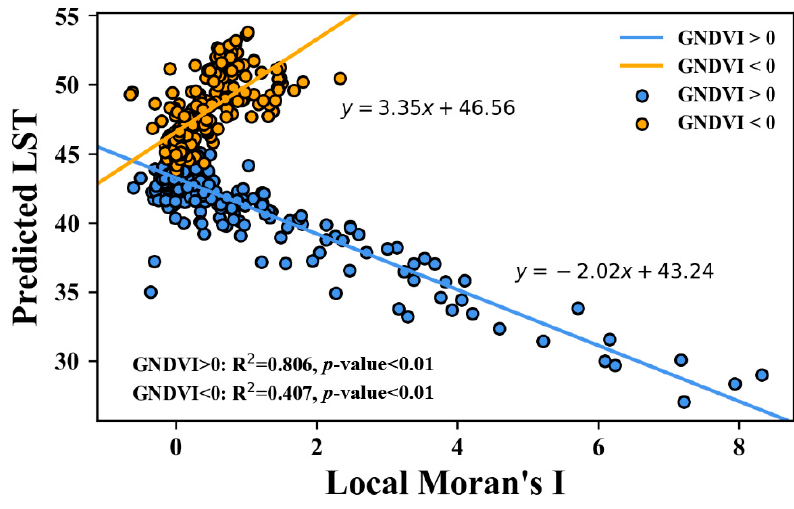
Figure 7. Interaction plot of predicted LST with the local Moran’s I for 2013.